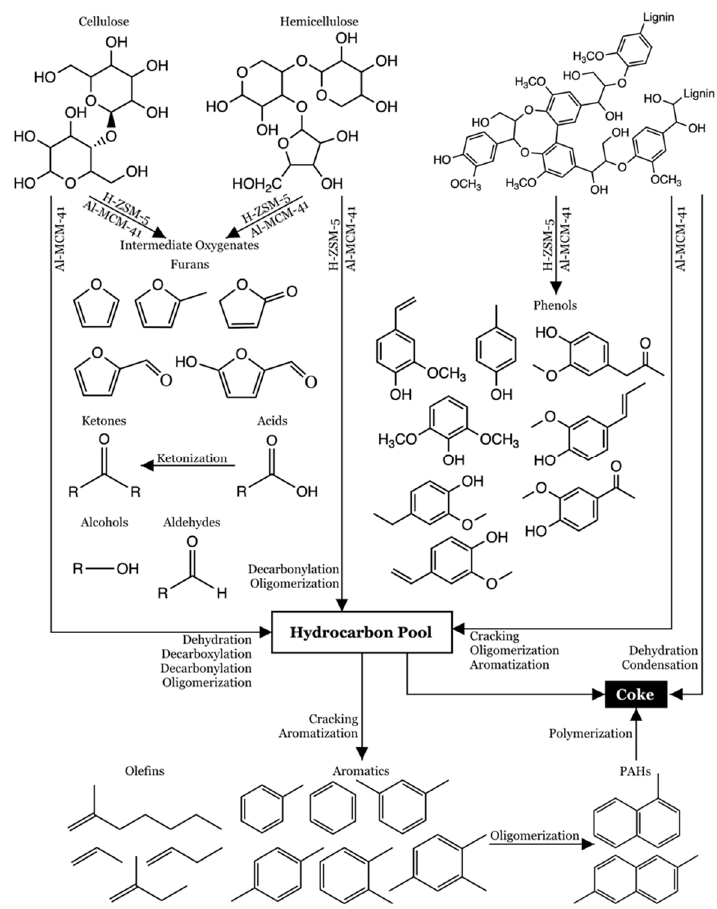
Figure 3 . Reaction pathways for lignocellulose biomass catalytic pyrolysis with an H-ZSM-5 and Al-MCM-41 catalyst mixture (adapted from Chi et al. [72], Jeenpadiphat et al. [73], and Wang et al. [71]).